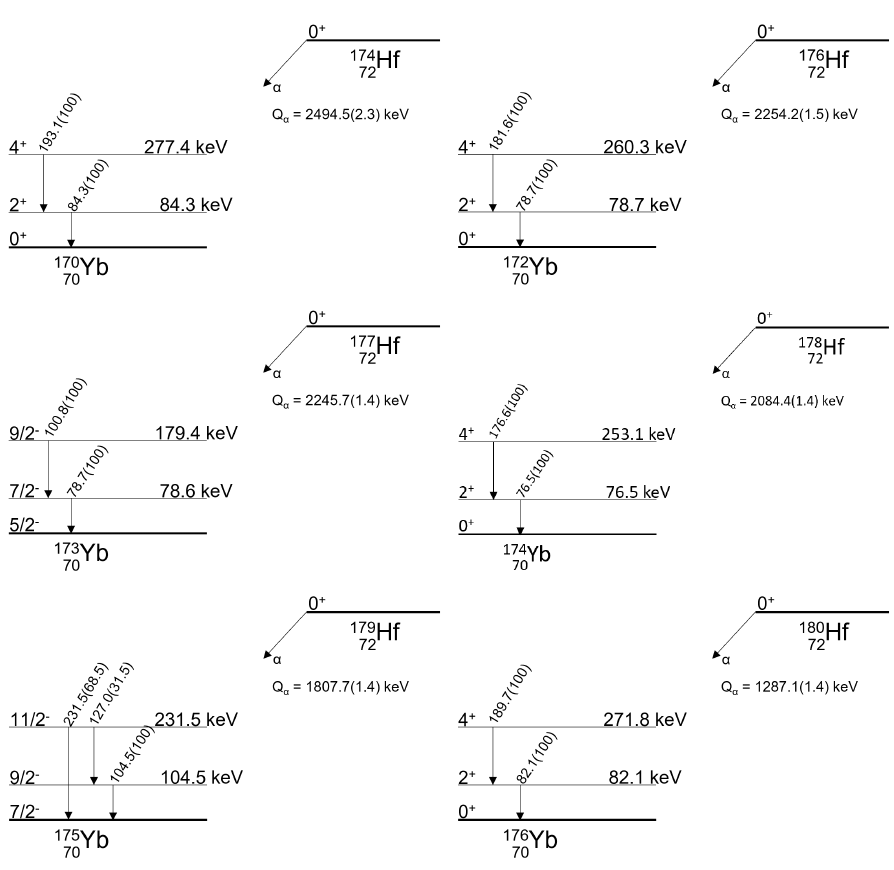
Figure 4. Simplified decay schemes of potential α decay of Hf isotopes considering the first two energy levels of the daughter nuclei. The corresponding gamma transitions and the probability related for a single energy level are also shown. The 175 Yb isotope is unstable via β − decay with T 1/2 = 4.185 ( 1 ) d [36], all the other Yb nuclei are